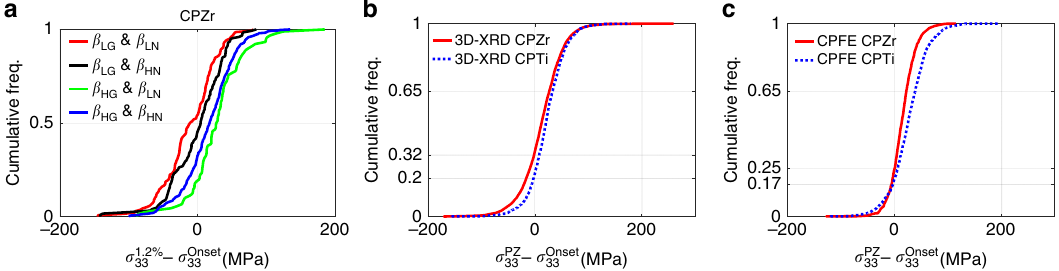
Fig. 7 Stress drop in CPTi and CPZr samples. Cumulative frequency of stress drop: ( a ) for different grain neighbours, b for all of the measured grains with their corresponding CPFE results shown in c . β represent the angle between loading direction and the crystal c -axis, subscripts HG, LG and N represent low β , high β and neighbouring grain, respectively. PZ refers to plastic zone where maximum strain of 1.2 and 0.94% was applied to CPZr and CPTi samples,